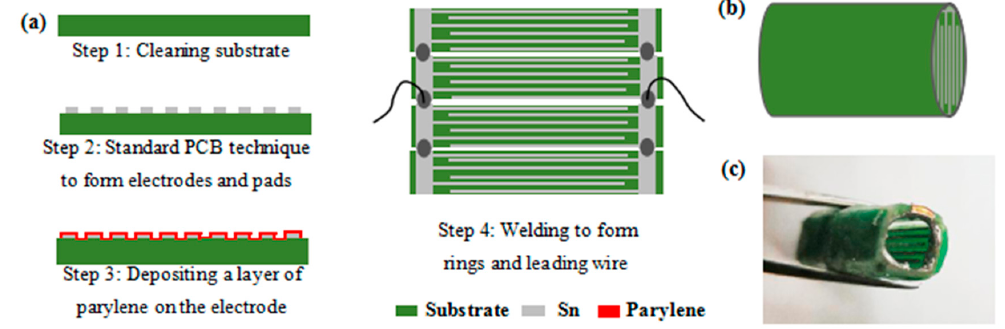
Figure 4. ( a ) Flowchart of the manufacturing process of the capacitive device for drainage monitoring. ( b ) Schematic of the approximate cylinder-shape capacitive device for drainage monitoring. ( c ) Photo of the capacitance device for drainage monitoring.